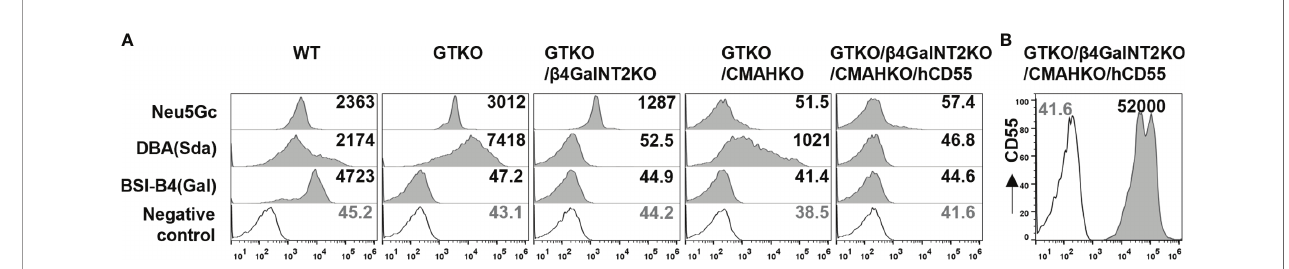
FIGURE 1 | Expression of Gal, Sda, and Neu5Gc on pig PBMCs. (A) The expression of Gal, Sda, and Neu5Gc on pig PBMCs from wildtype (WT), GTKO, GTKO/ b 4GalNT2KO, GTKO/CMAHKO, and TKO/hCD55 pigs (Gmean values were shown). White histograms outlined in black represent negative controls that were unstained cells for lectin experiments. (B) The expression of human CD55 (hCD55) on TKO/hCD55 pig